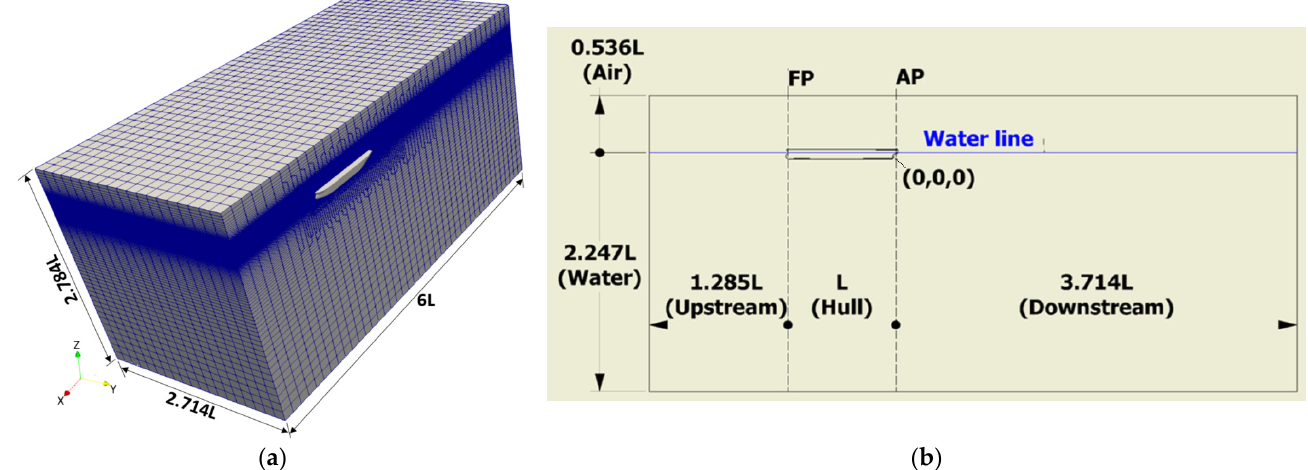
Figure 3. Computational domain: ( a ) boundary grid distribution, domain length, width and height (medium grid); and ( b ) side view of the computational domain.